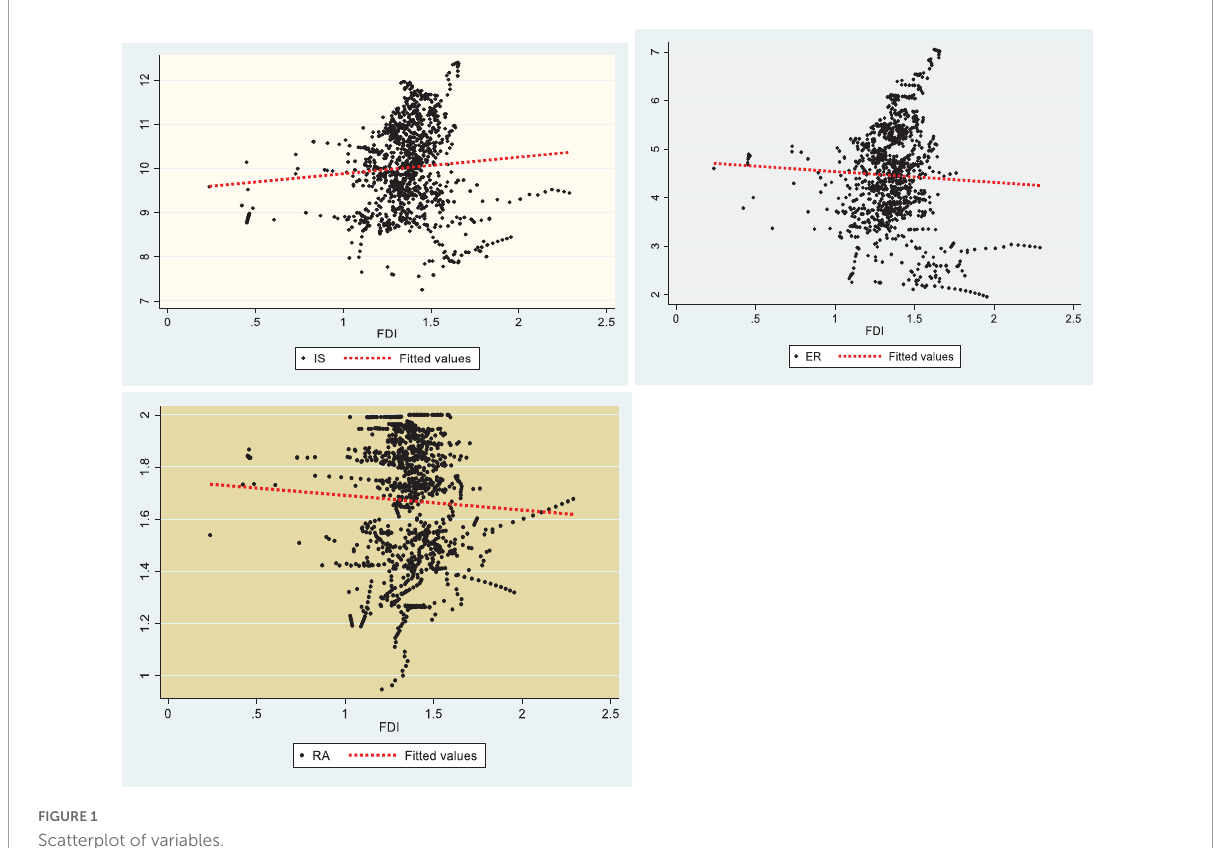
FIGURE1 Scatterplot of